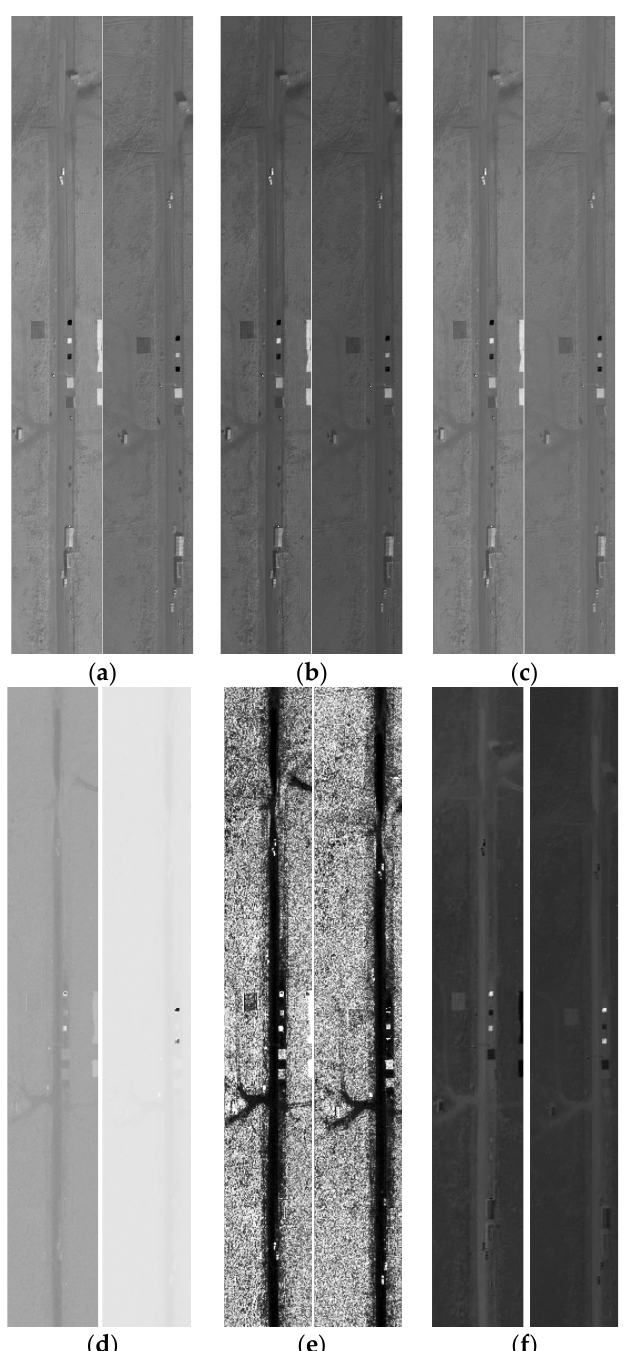
Figure 4. Generated 2D maps for the sample pair LWIR1 a (left) and LWIR1 b (right). ( a ) Brightness temperature estimate; ( b ) average energy of radiance spectrum for each pixel; ( c ) 1st PCA component of radiance spectra; ( d ) average energy of emissivity component for each pixel; ( e ) average energy of emissivity components for each pixel after histogram equalization; ( f ) 1st PCA component of emissivity